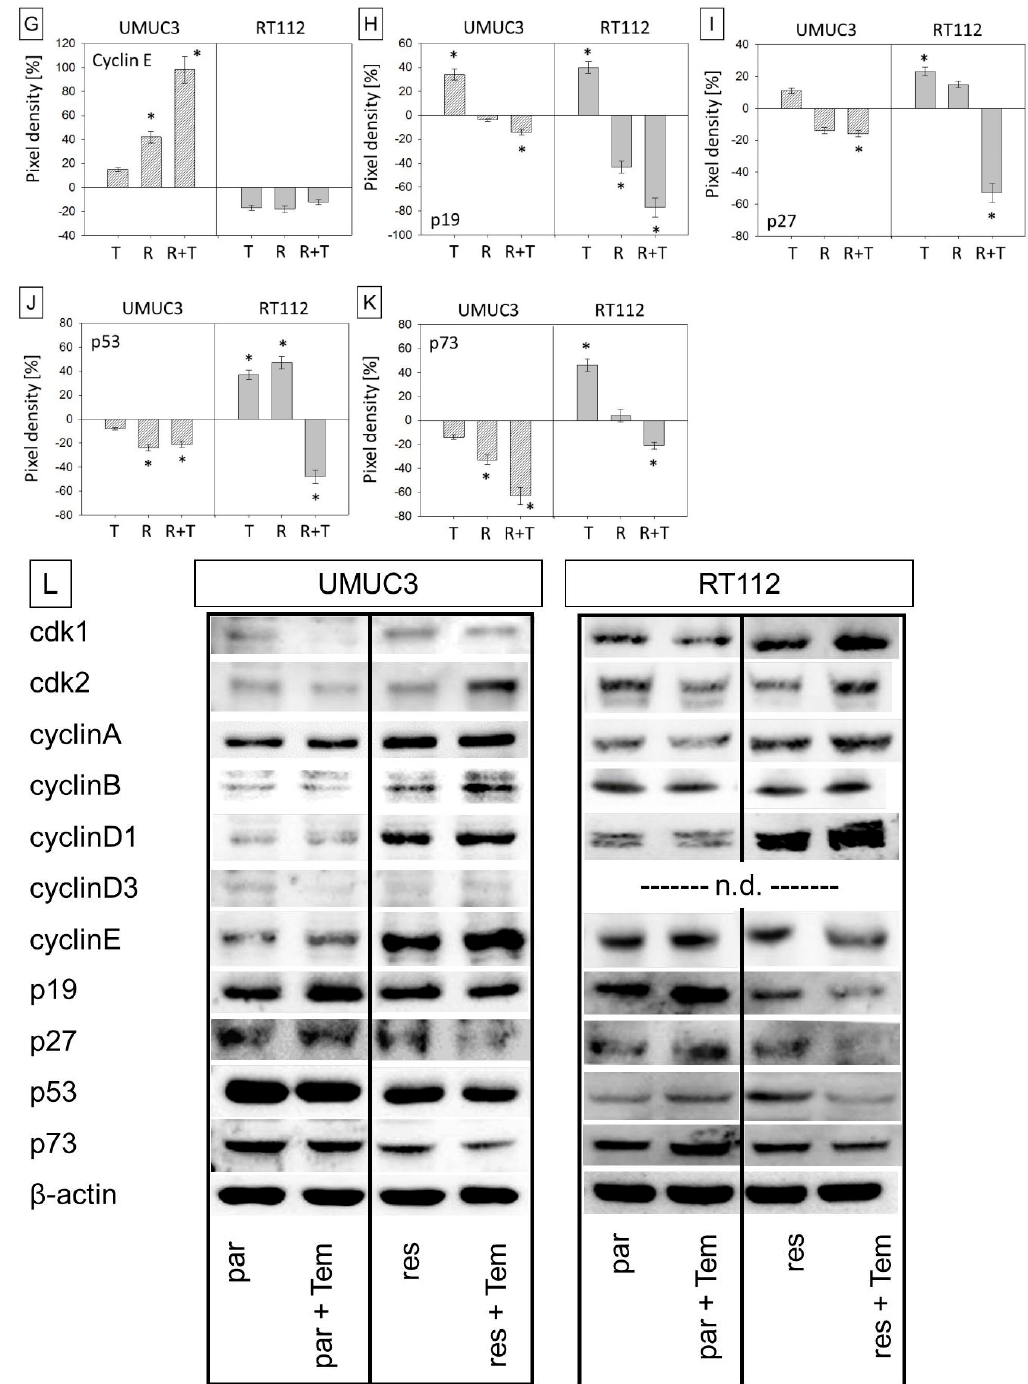
Figure 3. Protein expression profile of cell cycle regulating proteins. ( A – K ) Pixel density analysis of the protein expression in parental and temsirolimus-resistant UMUC-3 and RT112 cells after 72 h exposure to temsirolimus [10 nmol/mL]. All values are given in percentage difference to the parental control (set to 0). T = parental cells + temsirolimus, R = resistant cells, R + T = resistant cells + temsirolimus. Bars indicate standard deviation (SD). * indicates significant difference to parental control (set to 0), p ≤ 0.05. n = 4. n.d. = not detectable. β -actin served as internal control. ( L ) Original western blots: One representative of four separate experiments is shown. Each protein analysis was accompanied by a β -actin loading control. One representative internal control is shown here.